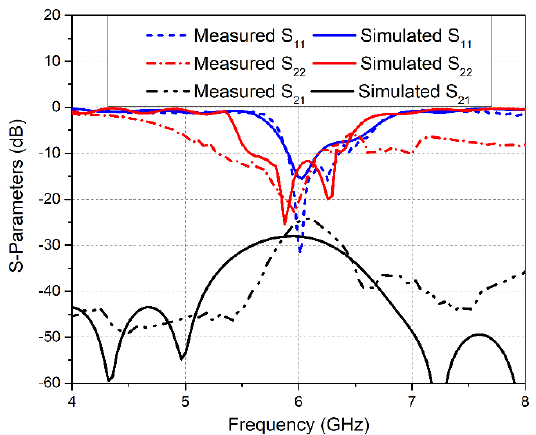
Figure 9. Simulated and Measured S-parameter Curves for LTE MIMO Antennas.